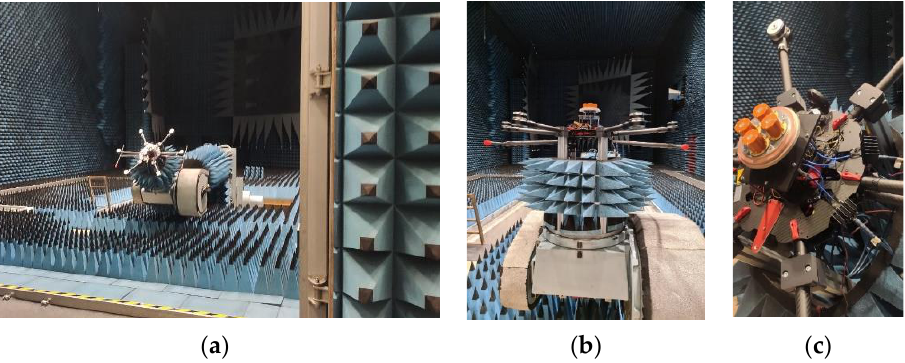
Figure 10. Installed performance measurement setup of the miniaturized GNSS antenna array on a hex-rotor UAV at the German Aerospace Center — Compact Test Range anechoic chamber. ( a ) View of the installed UAV in the measurement chamber; ( b ) Detailed view of UAV with antenna on the positioner; ( c ) Detailed view of the antenna with vertical choke rings installed on the UAV.